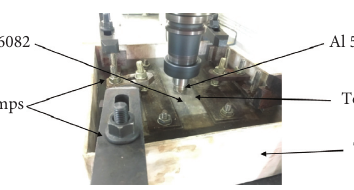
Figure 1: Submerged FSW set-up.